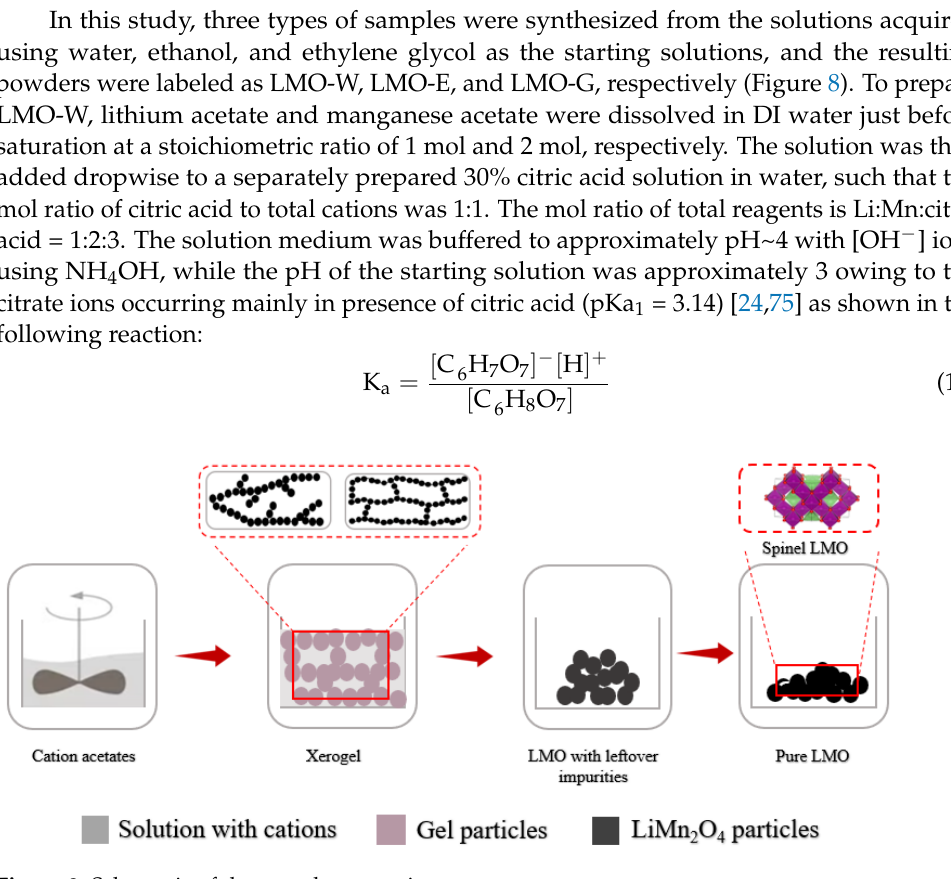
Figure 8. Schematic of the sample reparation process.